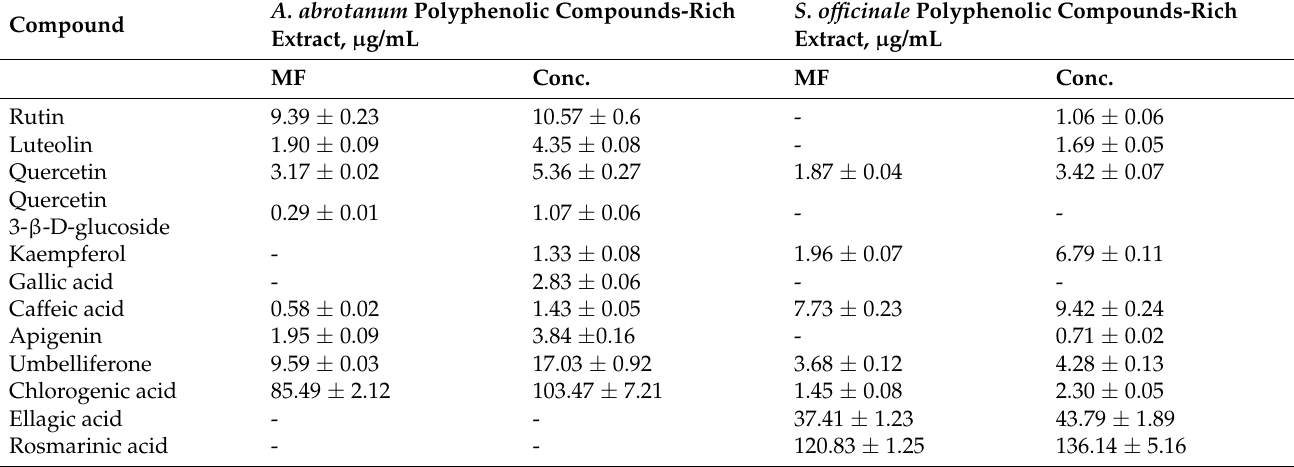
Table 2. The polyphenolic compound content found in the plant extracts by